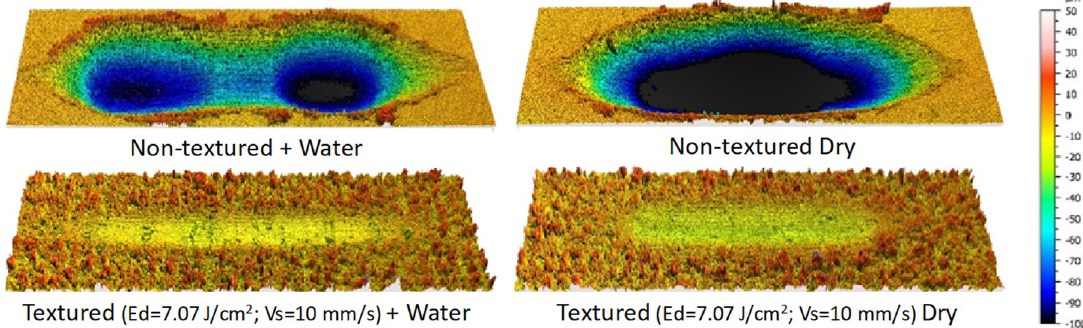
Figure 17. Effect of texturing treatment on wear track of dry and wet tribological tests.